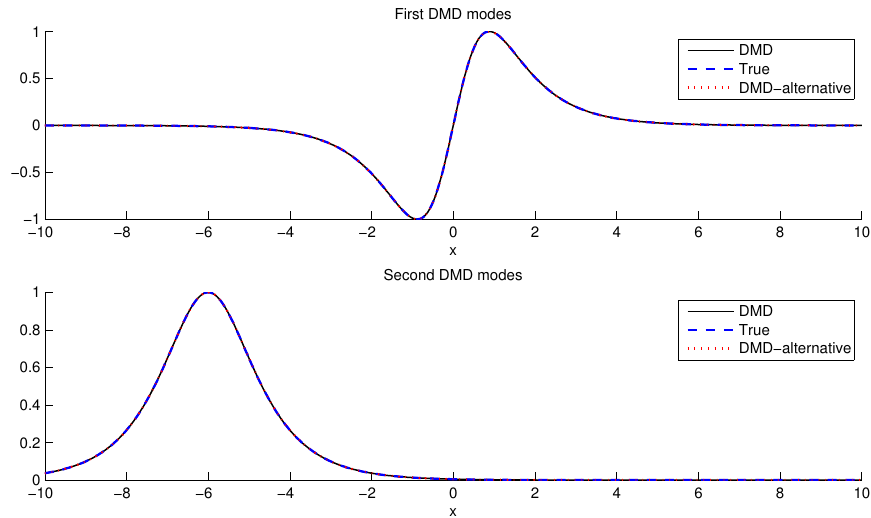
Figure 3. Firts two DMD modes: true modes, modes extracted by standard DMD and modes extracted by Alternative DMD.